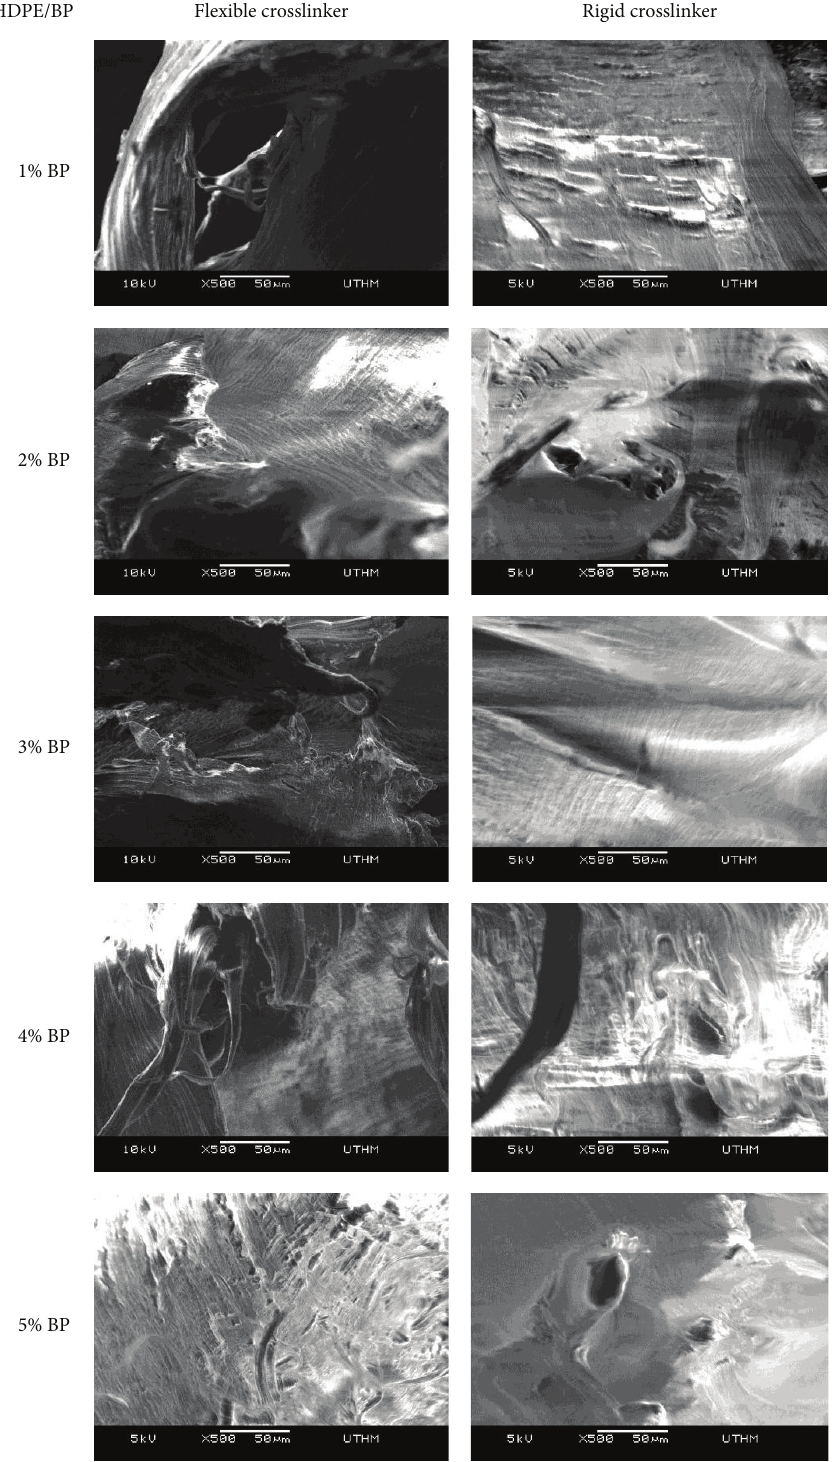
Figure 9: SEM images for all HDPE/BP specimens at 500x